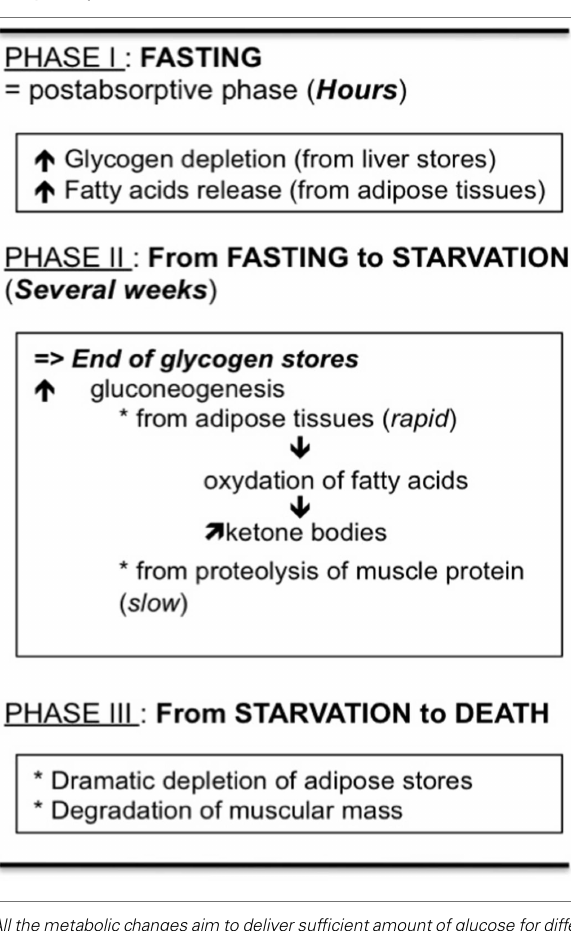
Table 1 | Different metabolic phases occurring during food restriction and permitting distinction between fasting and starvation (seeWang et al.,